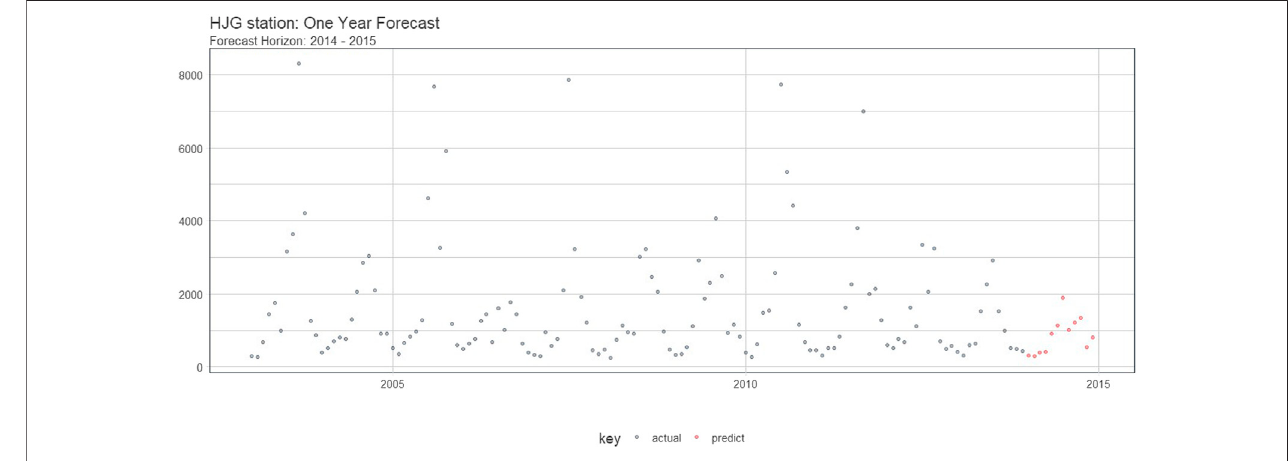
FIGURE 6 | Prediction results of 2014 – 2015 based on the LSTM.